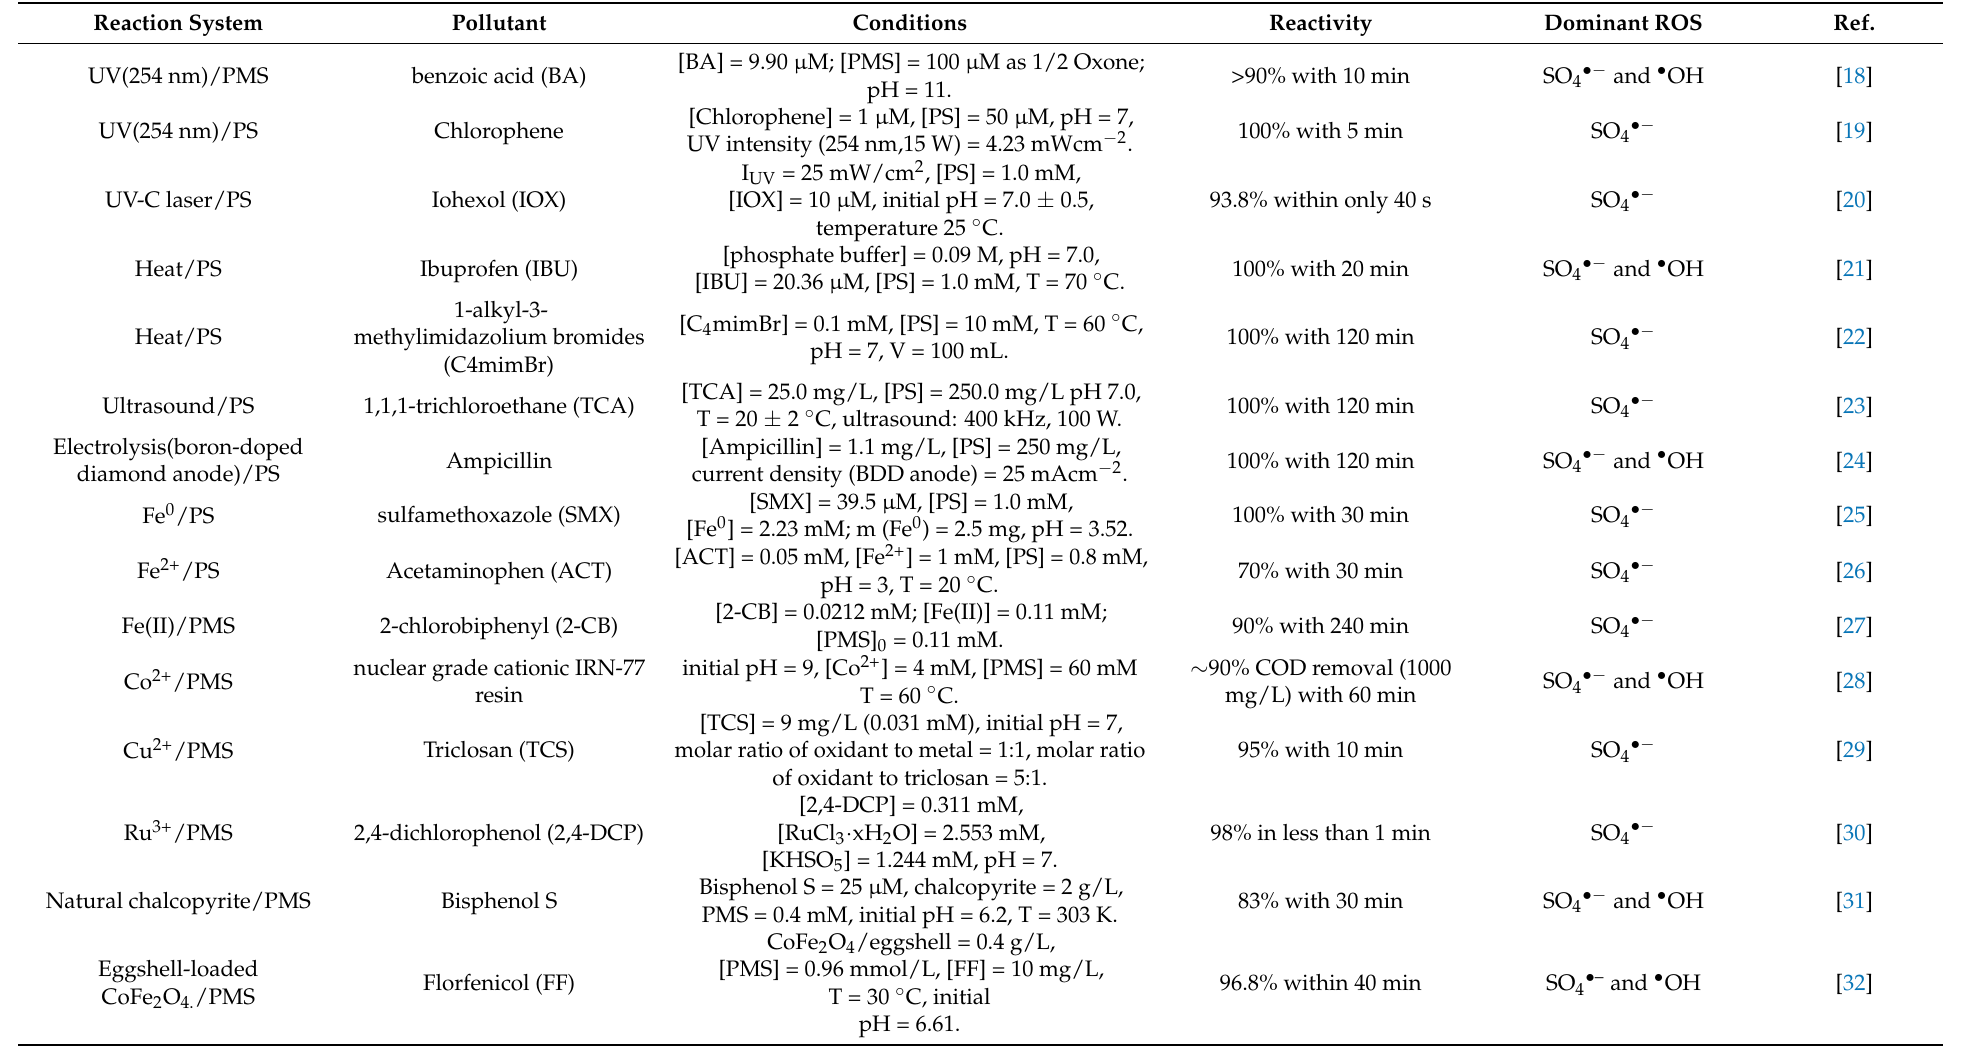
Table 2. PMS and PS radical activation with various method for the removal of